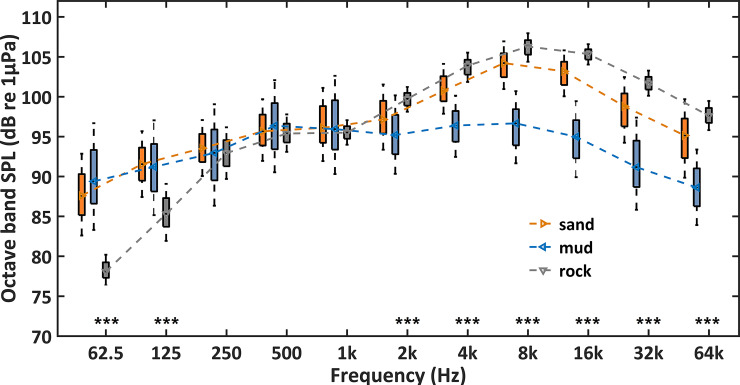
Comparison of octave band sound pressure levels (octave band SPLs) among different seabed environments.The three categories were muddy, sandy and rocky sea floors. Differences are marked with *** for p-level < 0.001 (Kruskal-Wallis test).